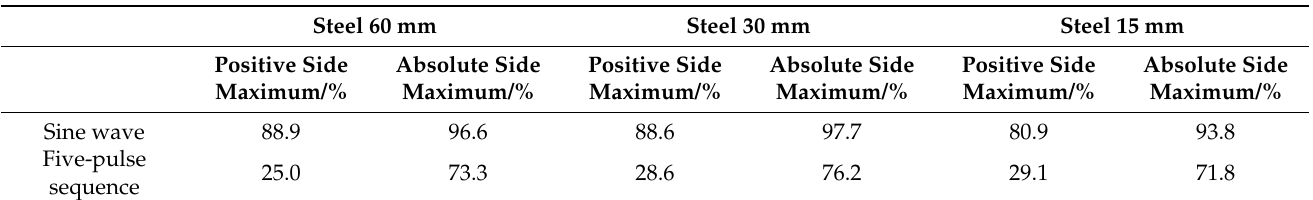
Table 2. Comparison of the magnitude of positive and absolute side maximum of the CCF for the validation measurements on the steel samples with different thicknesses.